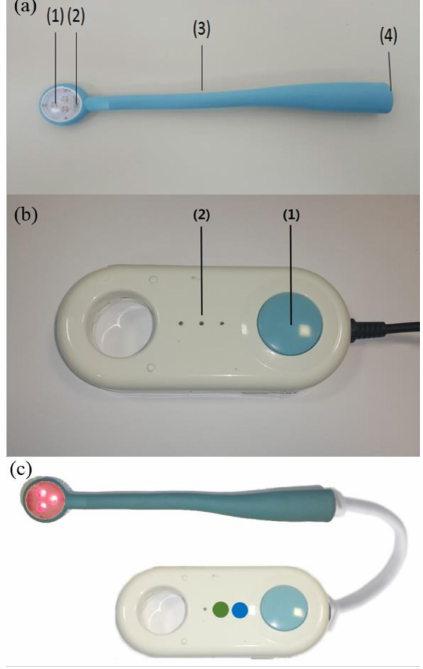
Figure 1. PetalB (Ptech Corp., Pyeongtaek, Republic of Korea). ( a ) Description of the laser irradiation part of PBMT device. (1) Laser irradiation unit; (2) laser irradiation part cover; (3) silicone handle; (4) main body connect port. ( b ) Description of the main body of PBMT device. (1) Device operation button; (2) operation indicator lamp. ( c ) Photos of laser being irradiated by connecting the main body and the laser irradiation